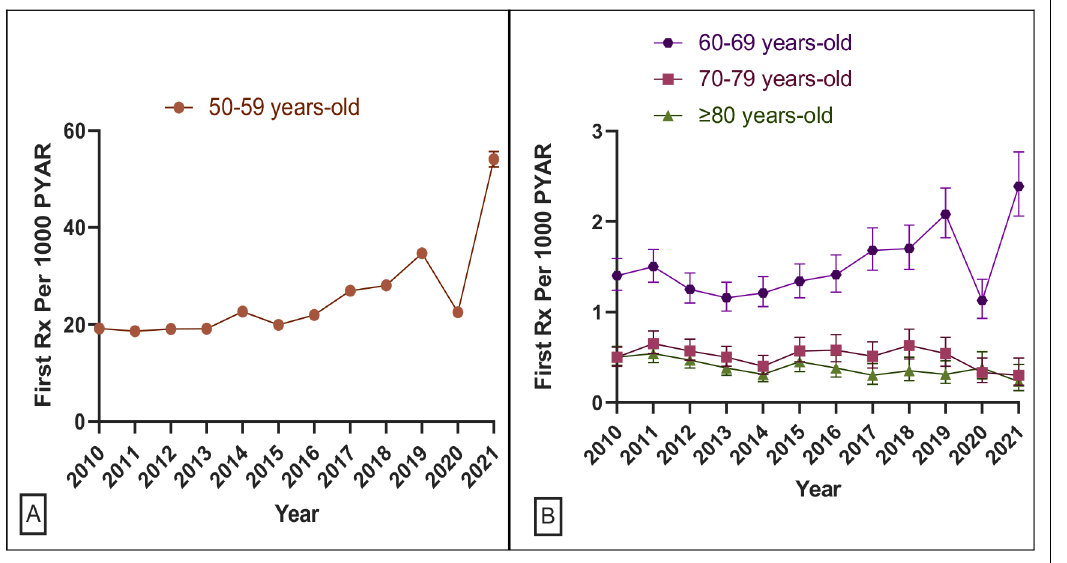
Figure 4 Annual incidence rate of prescribing of HRT medicines by age group. HRT = hormone replacement therapy. PYAR = person- year- at- risk. Rx = prescription.